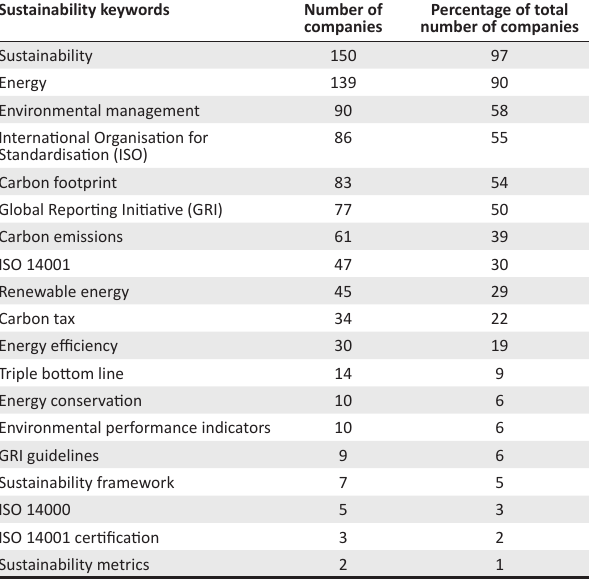
TABLE 3: Number of companies that mentioned each of the sustainability- related keywords.